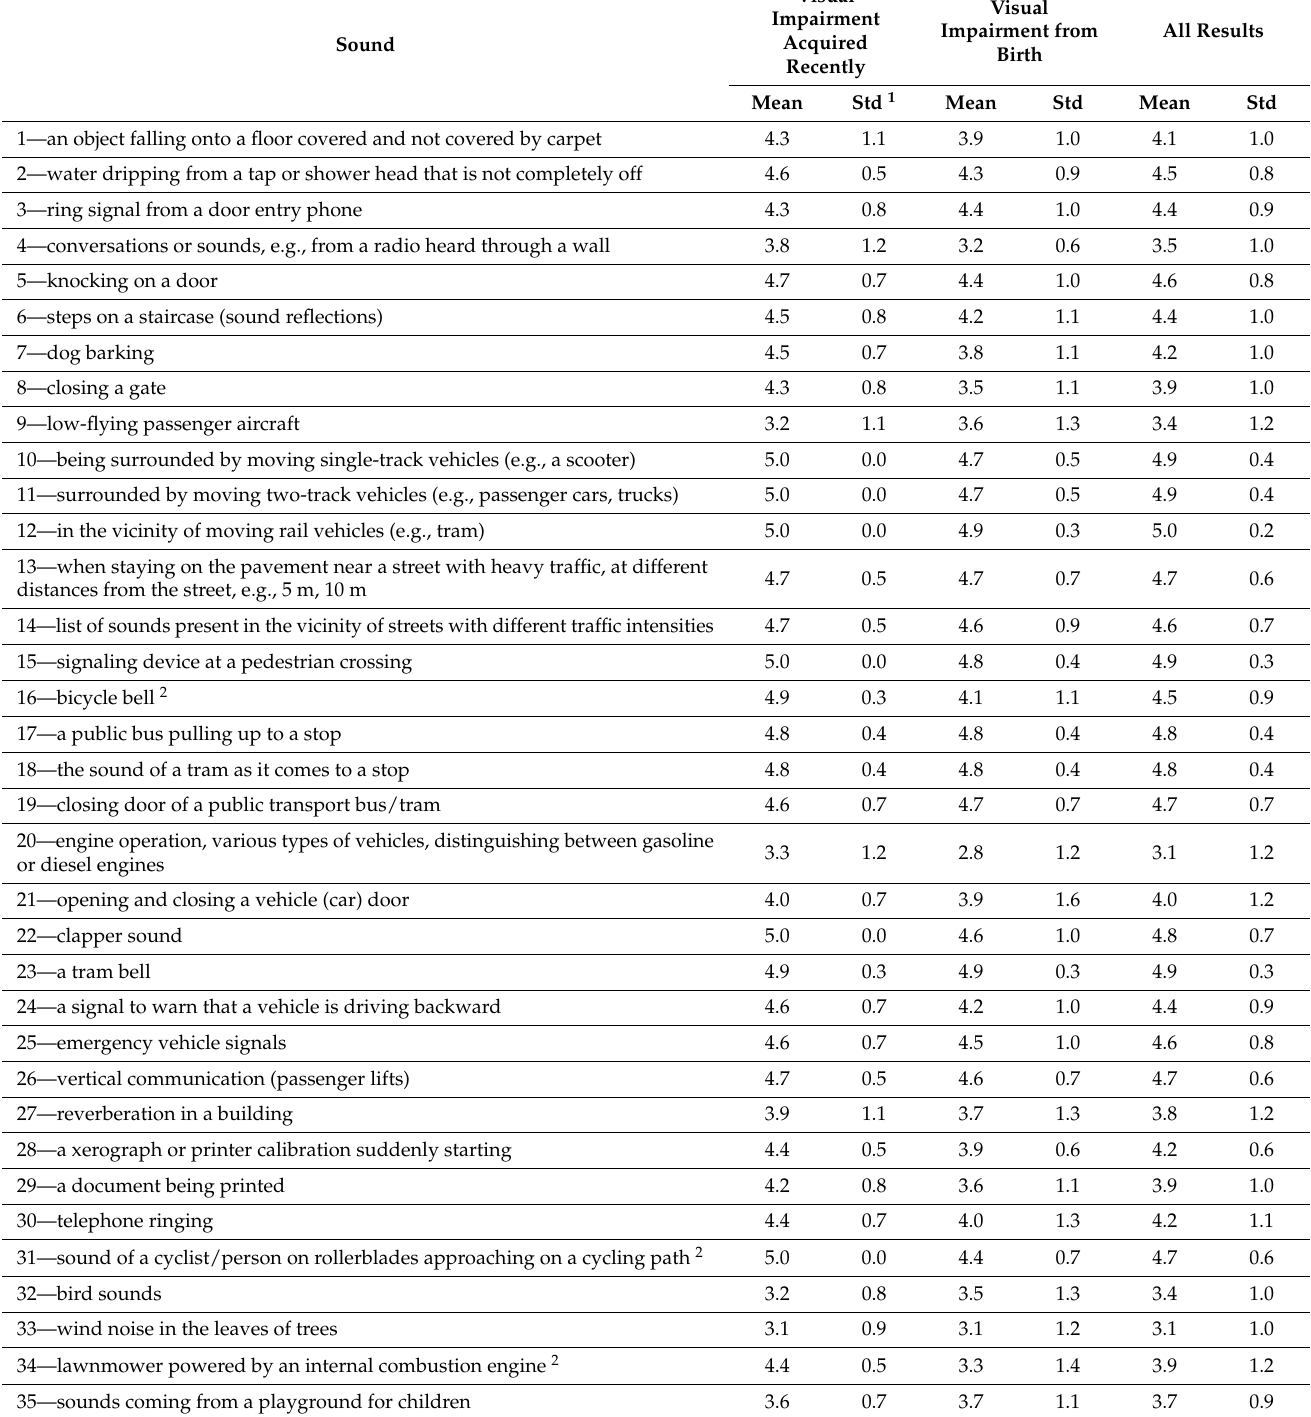
Table 2. Mean results and standard deviation values of the assessment of the proposed